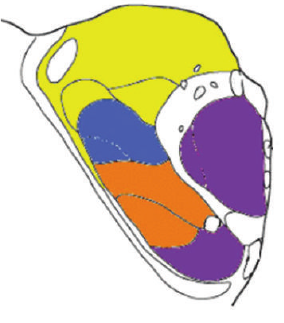
Figure 3: Hierarchical thalamus nuclei segmentation results of the right thalamus. (a) The right thalamus, h = ( h s , h r ) = (7,13) . (b) The segmented anterior and posterior parts of the right thalamus, h = ( h s , h r ) = (7,11) . (c) The segmentation result by setting the bandwidth parameter as h = ( h s , h r ) = (7,7) . (d) The segmented thalamus nuclei by setting the bandwidth parameter h = ( h s , h r ) = (1,1 . 5) .